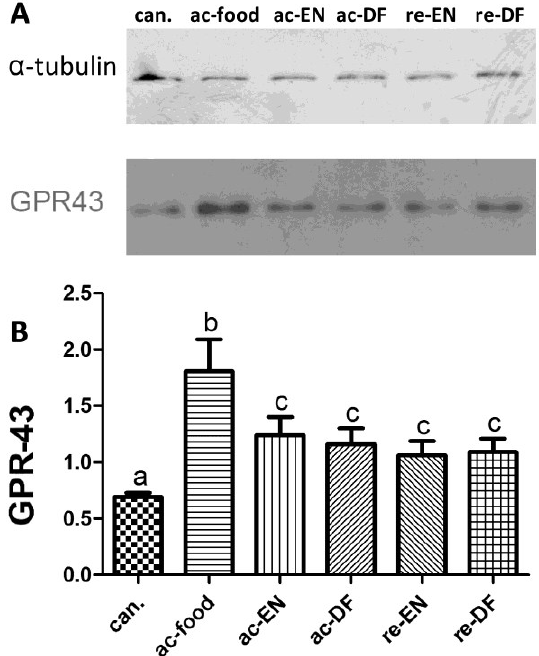
Figure 5. The expression of G-protein coupled receptor 43 (GPR43) in white blood cells from peripheral blood (can. 0.69 ± 0.08, ac-food 1.81 ± 0.40, ac-EN 1.24 ± 0.18, ac-DF 1.16 ± 0.20, re-EN 1.06 ± 0.28, and re-DF 1.09 ± 0.27). Columns with different letters are significantly different (a vs. c p < 0.05, b vs. a and c p < 0.01). GPR43 from white blood cell (WBC) of